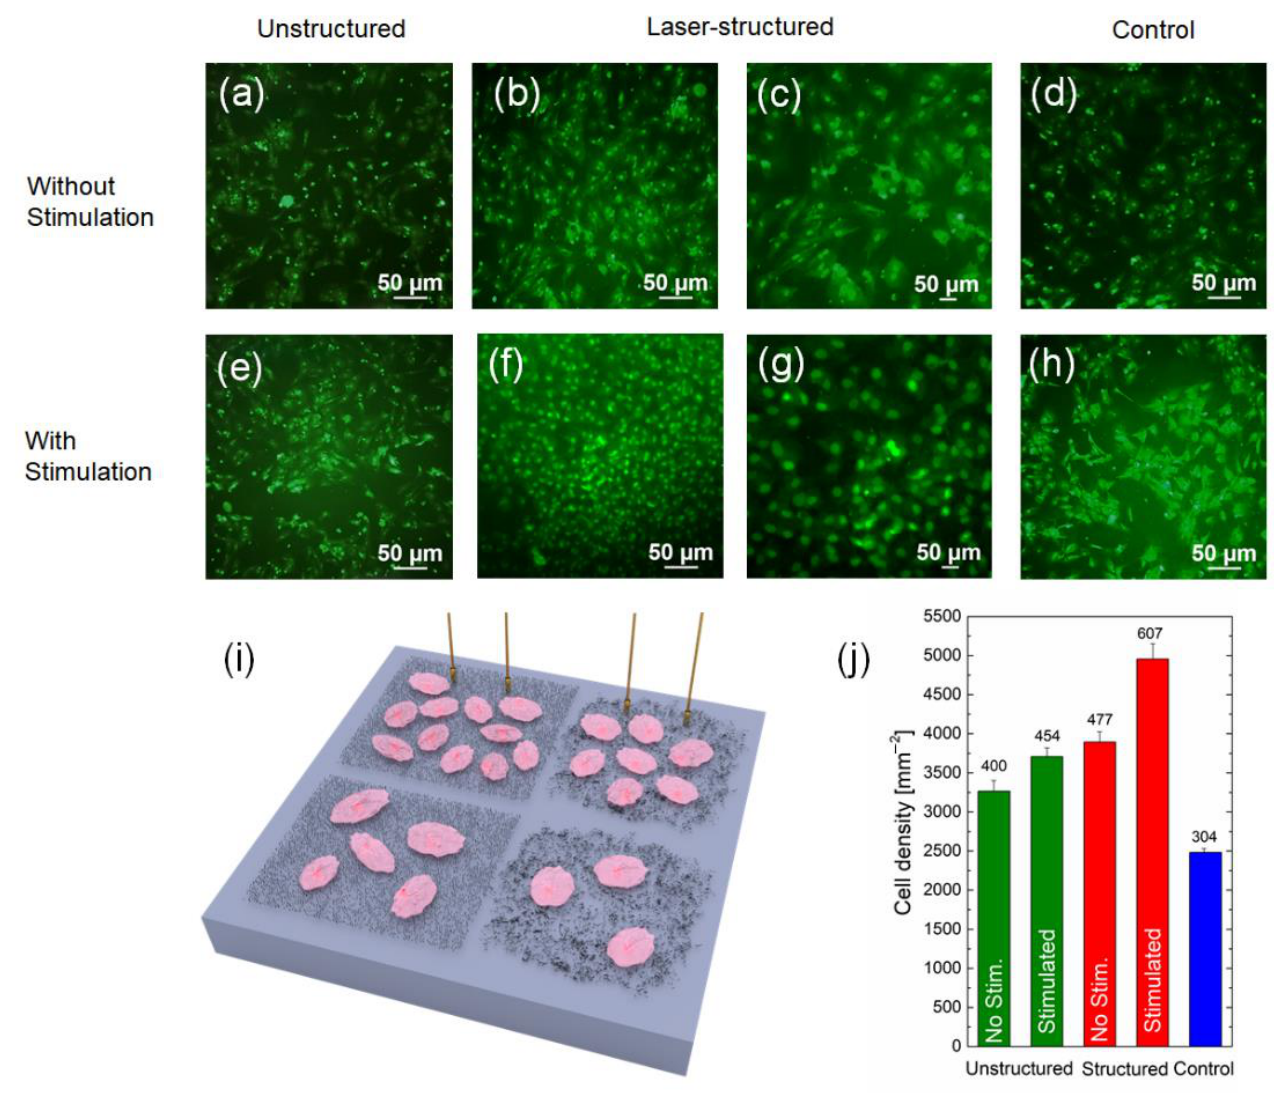
Figure 7. Examples of fluorescence microscope images of cardiomyocytes cell cultures on Si substrates 24 h in vitro with unstructured ( a , e ) and laser-structured ( b , c , f , g ) MWCNT arrays with BSA grown with ( e – g ) and without ( a – c ) electrical stimulation, and control samples ( d , h ). The scale bar for ( a – h ) is 50 µm. Schematic of cardiomyocytes grown on a Si substrate with various conditions used in the experiment ( i ). The values on the bars in ( j ) represent the total number of live cells averaged over several areas of size 350 µm × 350 µm (0.1225 mm 2 ). The results from three images on three different samples for each type of the condition were averaged for the statistics; n = 9.